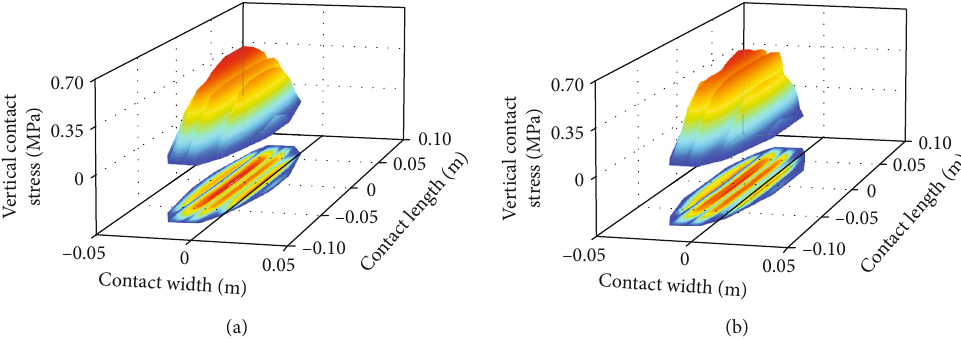
Figure 11: Contact patch and pressure distribution during steering with a 20 ° roll angle: (a) control tire; (b) bionic tire.